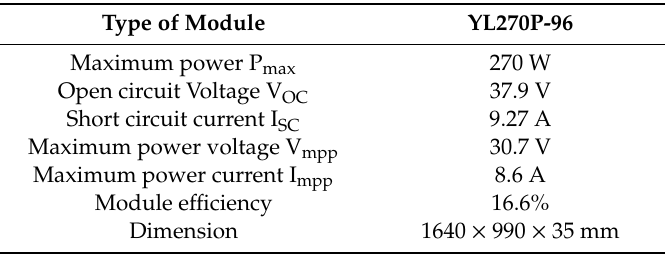
Table 1. PV panels’